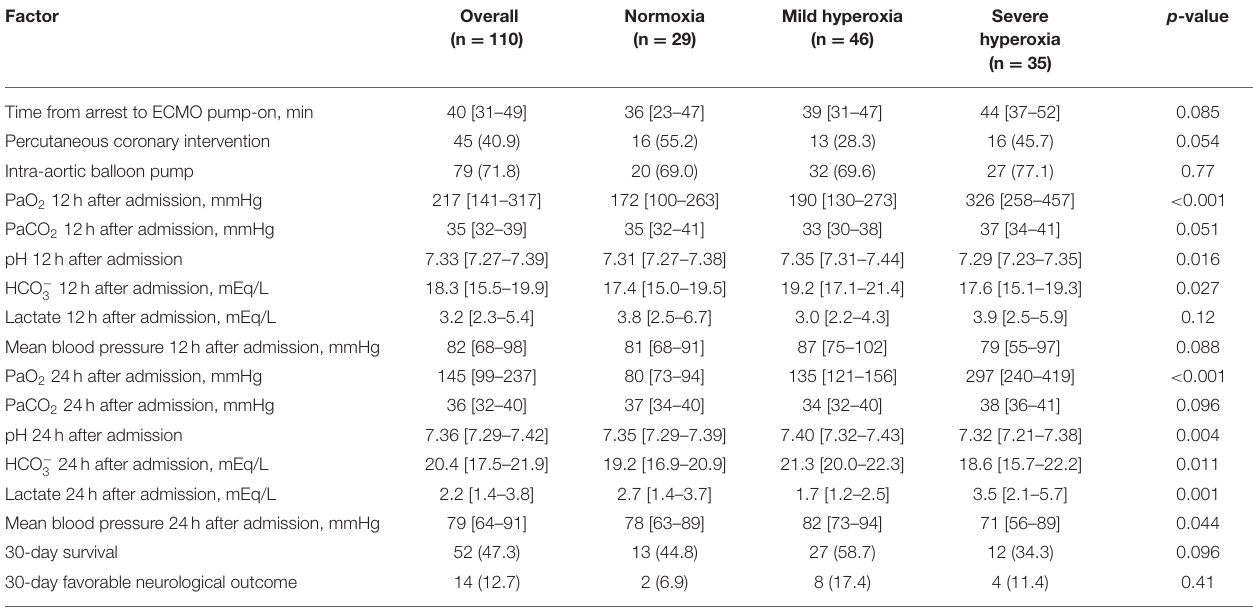
p -value Normoxia Mild hyperoxia Severe (n = 110) (n = 29) (n = 46) hyperoxia (n = 35)